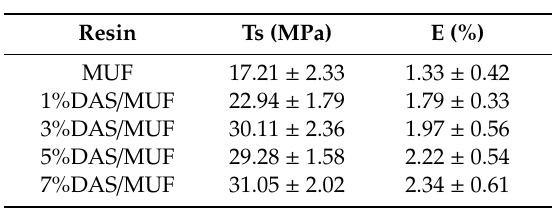
Table 4. Tensile strength (Ts) and Elongation at break (E) of the filter papers impregnated by the neat and DAS-modified MUF resins with di ff erent DAS